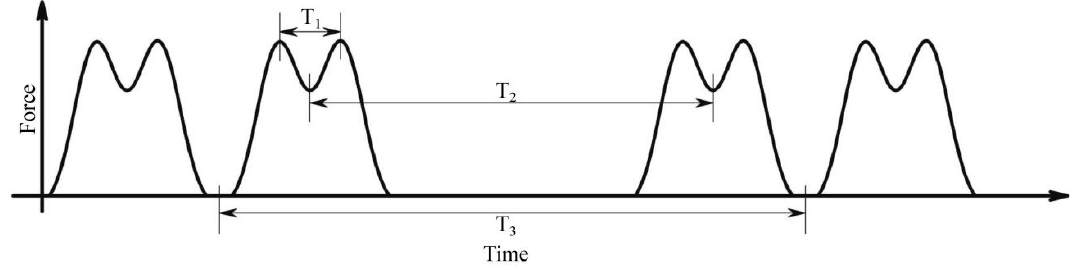
Figure 3. Schematic layout of monitoring points.